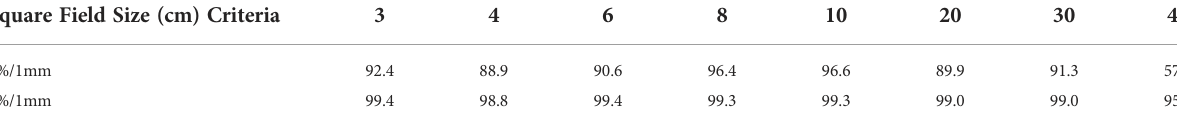
TABLE 5 Gamma analysis results for the open fi elds between TB-10MV and E syn -10MV photon beams. Square Field Size (cm)